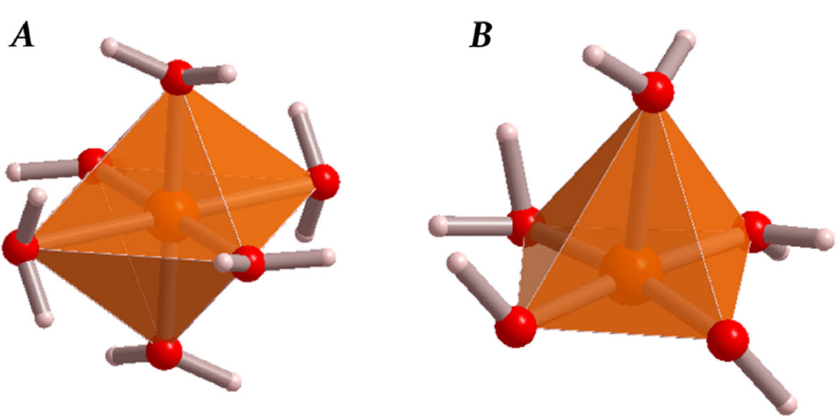
Figure 5. Structure of the Cu coordination polyhedra in mineral pseudojohannite: ( A ) Cu1 coordi ‐ nation polyhedron; ( B ) Cu 2 coordination polyhedron. Color code: Cu—orange; S—yellow; O—red; H—white.